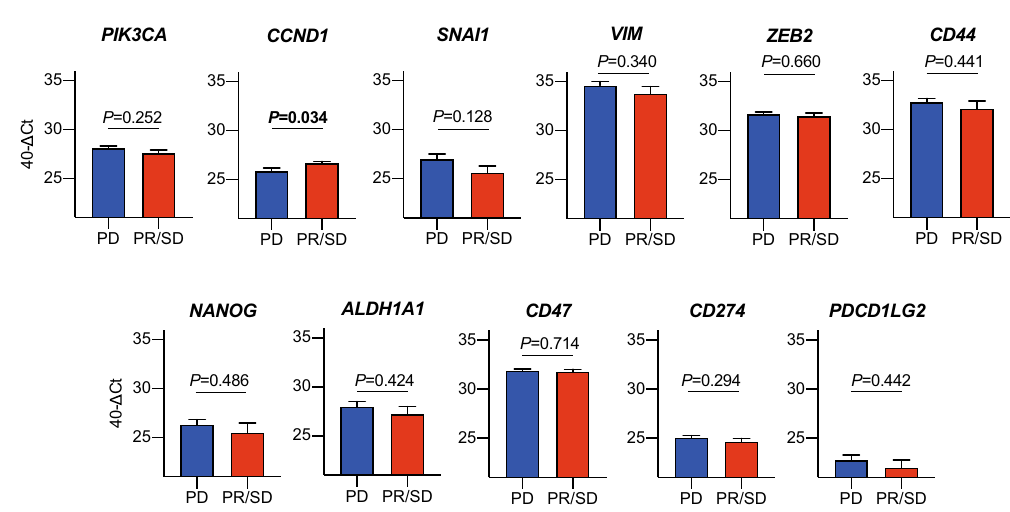
Figure 2. Gene expression in CTCs and treatment responses. The patients with CTCs were divided into two groups according to treatment responses: the disease-controlled group and disease-progressed group. Eleven gene expressions in CTCs were compared.